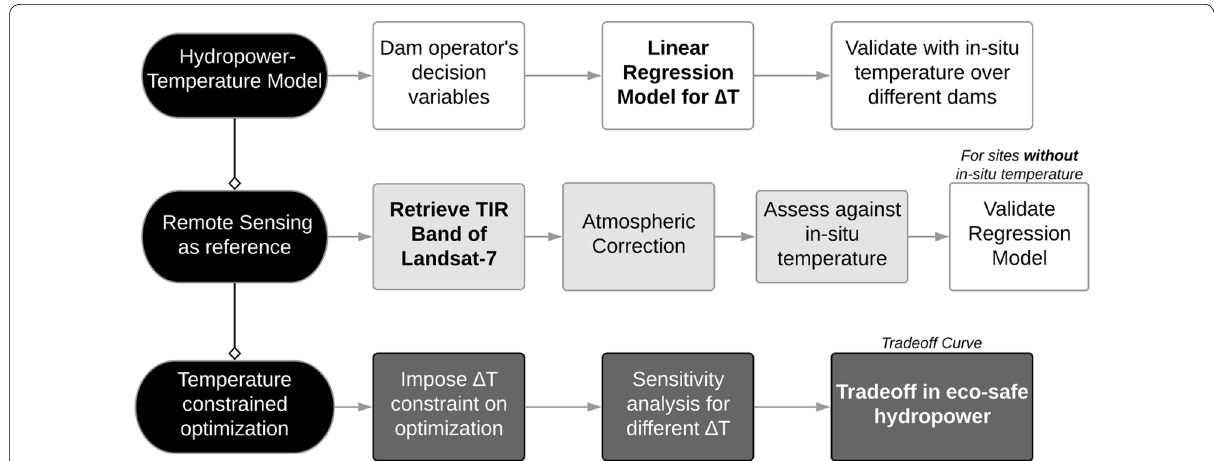
Fig. 5 Experimental approach showing development of the temperature model, validation using remote sensing and its integration with the reservoir operations optimization to realize tradeoffs in ecosystem-safe hydropower